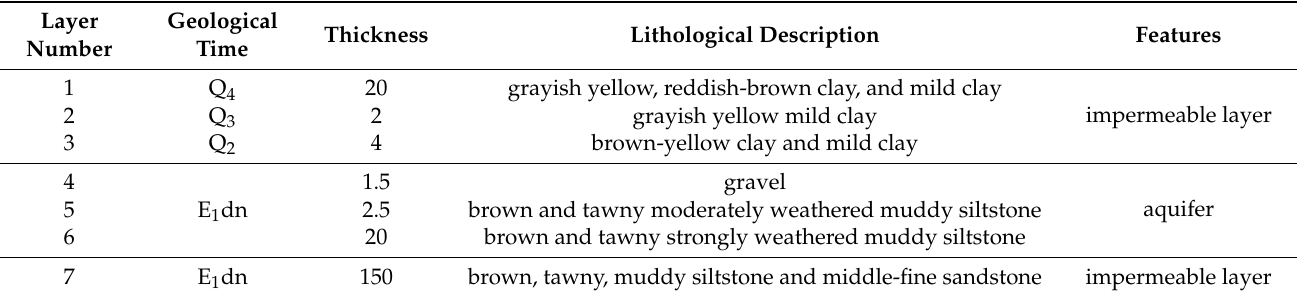
Table 1. Stratification table of the strata in the study